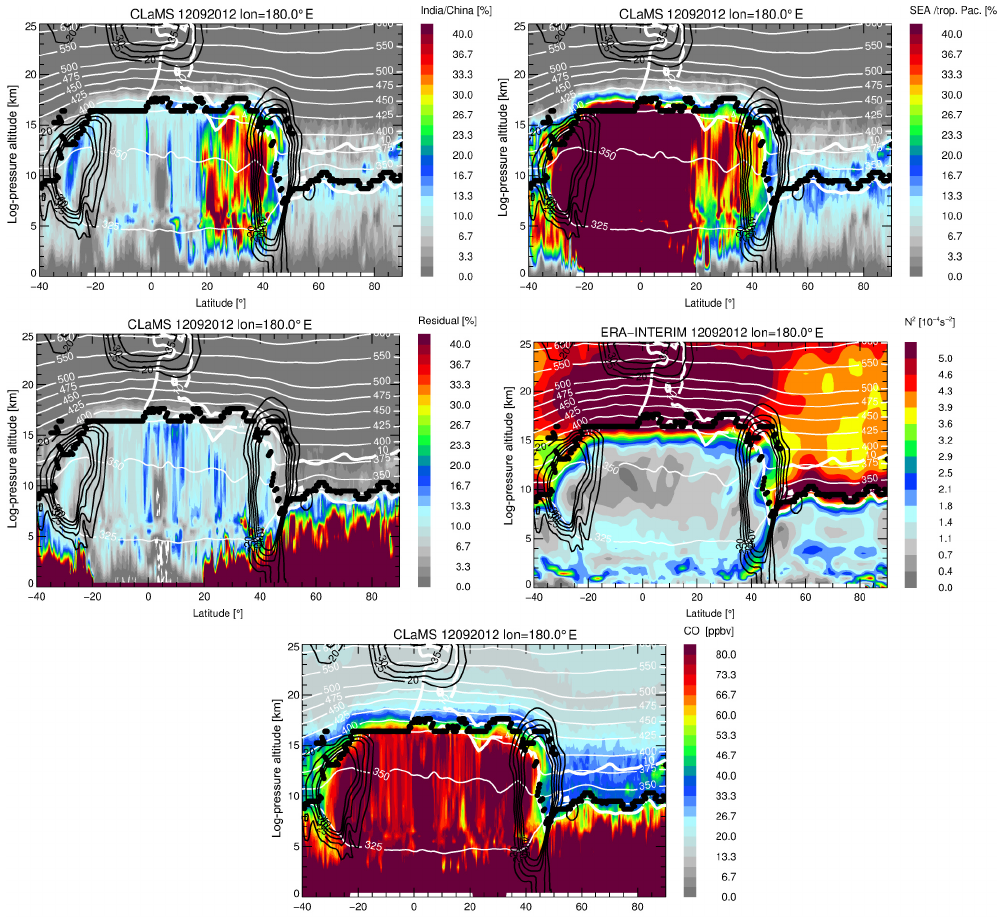
Figure 5. Latitude–height cross sections from 40 ◦ S to 90 ◦ N at 180 ◦ E longitude on 20 September 2012 including the separated anticyclone ( ≈ 25–45 ◦ N) caused by an eddy-shedding event for the fraction of air originating in India/China (top left), the fraction of air originating in southeast Asia/tropical Pacific Ocean (top right), the fraction of air originating in the residual surface (bottom left), and buoyancy frequency squared N 2 (bottom right). The climatological isentropic transport barriers of 4 and 10PVU at 350 and 400K, respectively, for September (thick white lines) and thermal tropopause (black dots) are shown. The corresponding levels of potential temperature are marked by thin white